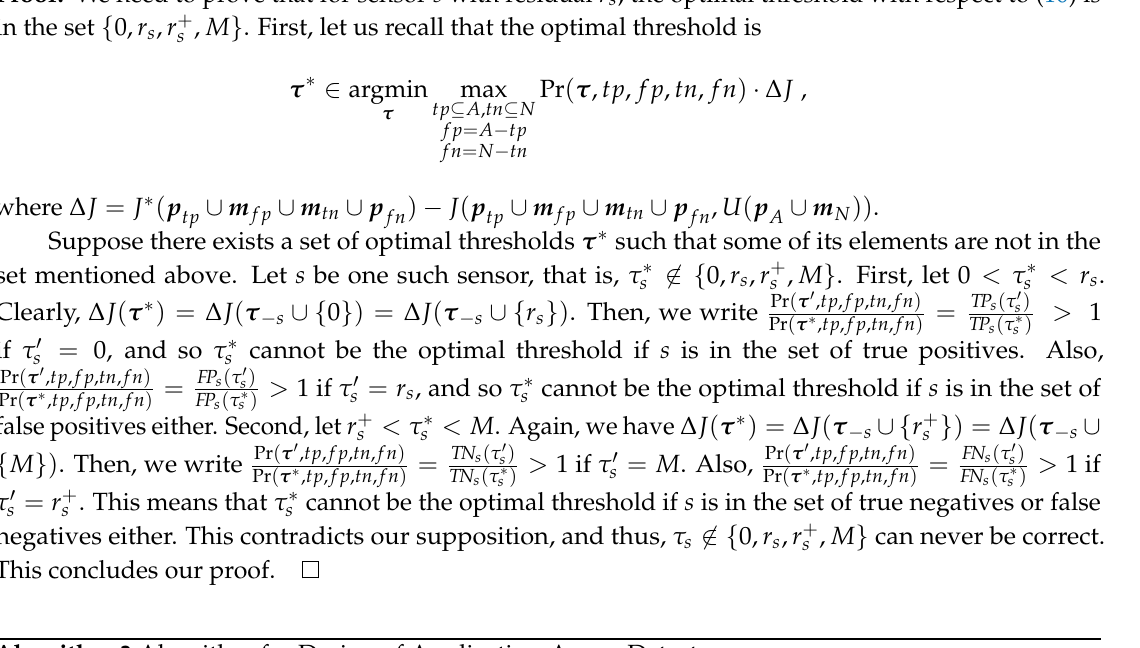
Algorithm 3 Algorithm for Design of Application-Aware